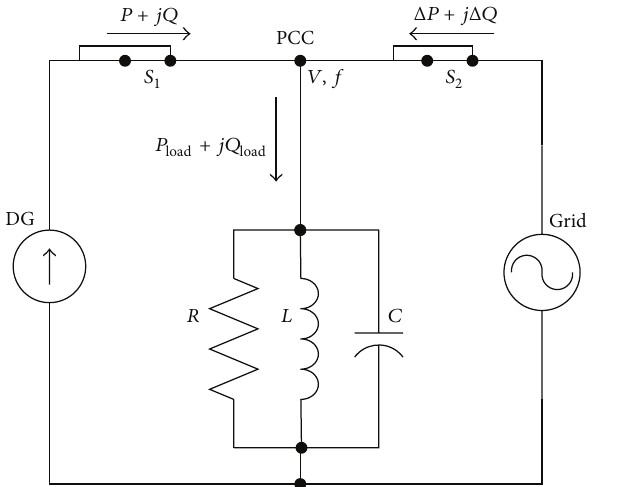
Figure 3: Equivalent circuit of grid-connected DG power genera- tion system.